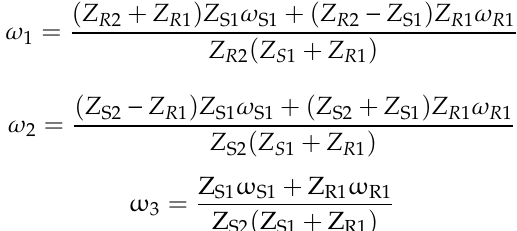
Figure 2. Layout of the HSU of the HMT prototype tractor used in this study.